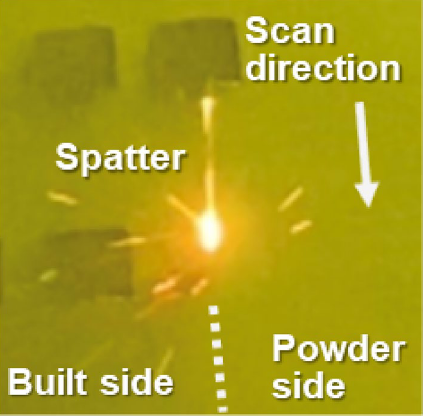
Figure 2. CCD camera image of laser scanning onto the